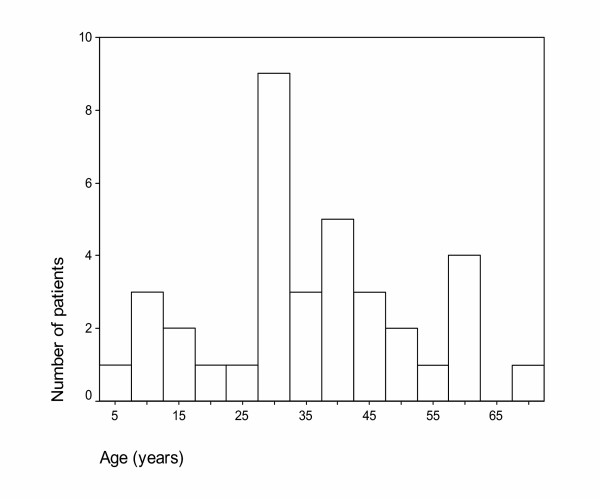
Age distribution of patients (n = 38)